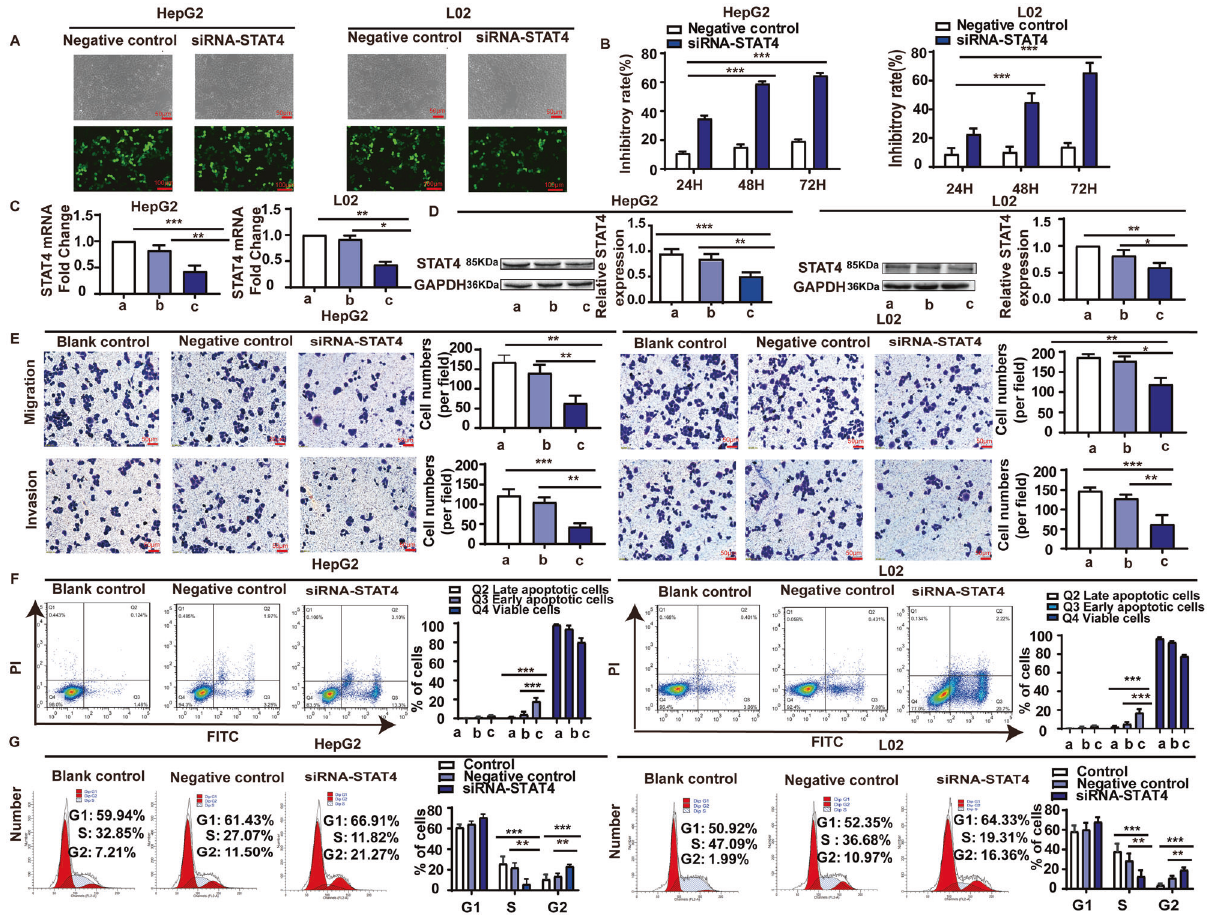
Fig. 2 The effect of STAT4 on apoptosis, growth cycle, migration, and invasion in HepG2 and L02 cells. A The transfection ef fi ciency was determined under a fl uorescent microscope 48 h after transfection. The fl uorescent siRNA (green) is evident in HepG2 and L02 cells. B Inhibition of cell proliferation by MTT assay at different time in HepG2 and L02 cells. C mRNA expression of STAT4 in HepG2 and L02 cells estimated by qPCR. D Expression of STAT4 and GAPDH in protein extracts from cultured HepG2 and L02 cells after 48 h by Western blot. Quanti fi cation of STAT4 is shown in the right picture. Data are representative of three independent experiments. E STAT4 siRNA inhibited the migration and invasion of HepG2 and L02 cells lines. F STAT4 siRNA promoted apoptosis in HepG2 and L02 cells. G STAT4 siRNA affected